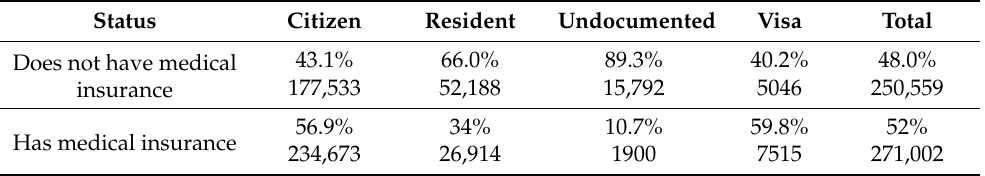
Table 2. Medical Insurance by Citizenship among Hispanics in El Paso, TX in